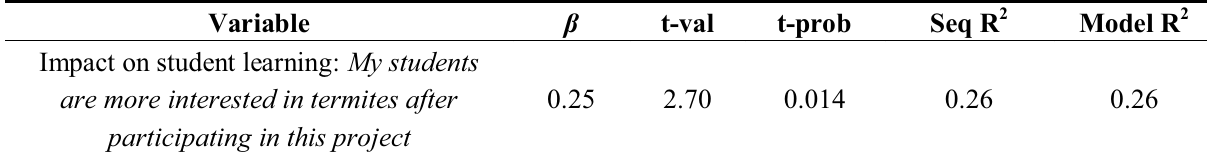
Table 7. (cid:53)(cid:72)(cid:74)(cid:85)(cid:72)(cid:86)(cid:86)(cid:76)(cid:82)(cid:81)(cid:3)(cid:82)(cid:73)(cid:3)(cid:21)(cid:22)(cid:3)(cid:83)(cid:68)(cid:85)(cid:87)(cid:81)(cid:72)(cid:85)(cid:3)(cid:87)(cid:72)(cid:68)(cid:70)(cid:75)(cid:72)(cid:85)(cid:86)(cid:182)(cid:3)(cid:83)(cid:85)(cid:82)(cid:77)(cid:72)(cid:70)(cid:87)(cid:3)(cid:70)(cid:82)(cid:81)(cid:87)(cid:76)(cid:81)(cid:88)(cid:68)(cid:87)(cid:76)(cid:82)(cid:81)(cid:3)(cid:82)(cid:81)(cid:3)(cid:83)(cid:72)(cid:85)(cid:70)(cid:72)(cid:83)(cid:87)(cid:76)(cid:82) ns of curriculum and teacher characteristics (survey